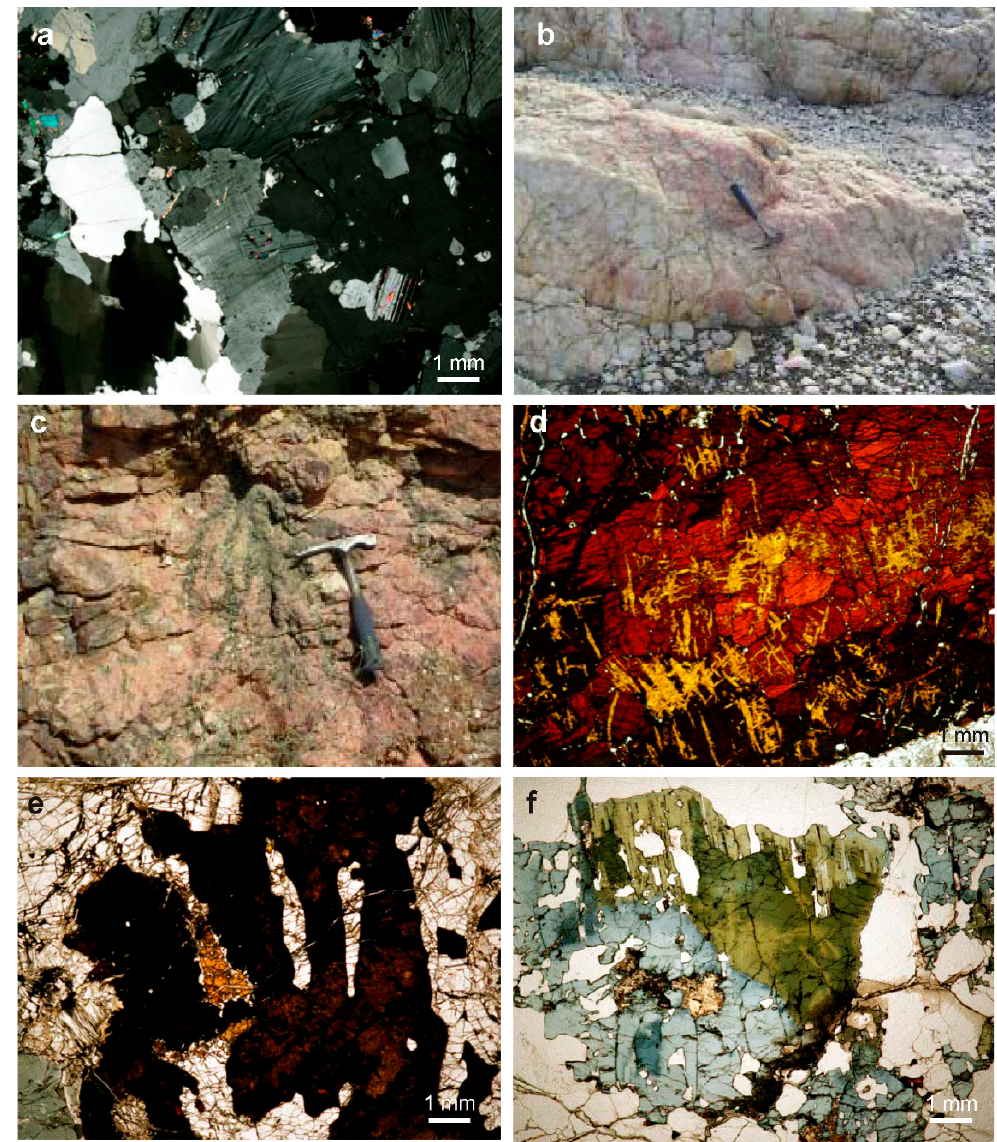
Figure 9. Textural patterns in pegmatites: ( a ) Microscope image of an intergrowth of microcline and quartz from the First intermediate zone of type-I pegmatites. ( b ) Large quartz core in type-I pegmatite, in which some areas with pink quartz are distinguished in a predominantly white core. ( c ) Skeletal crystals (or graphic intergrowths) of altered triphylite (dark) with reddish K-feldspar, in the first intermediate zone of a type-IV pegmatite. ( d ) Replacement of ferrisicklerite (orange) by heterosite (red); the whole is cut by alluaudite (greenish yellow). Thin section, PPL. ( e ) Skeletal intergrowths of triphylite altered to secondary phosphates; the interstitial material is albite. Thin section, PPL. ( f ) Skeletal crystals of tourmaline, strongly zoned, in graphic intergrowths with quartz, in the first intermediate zone of a type-IV pegmatite. Thin section, PPL.